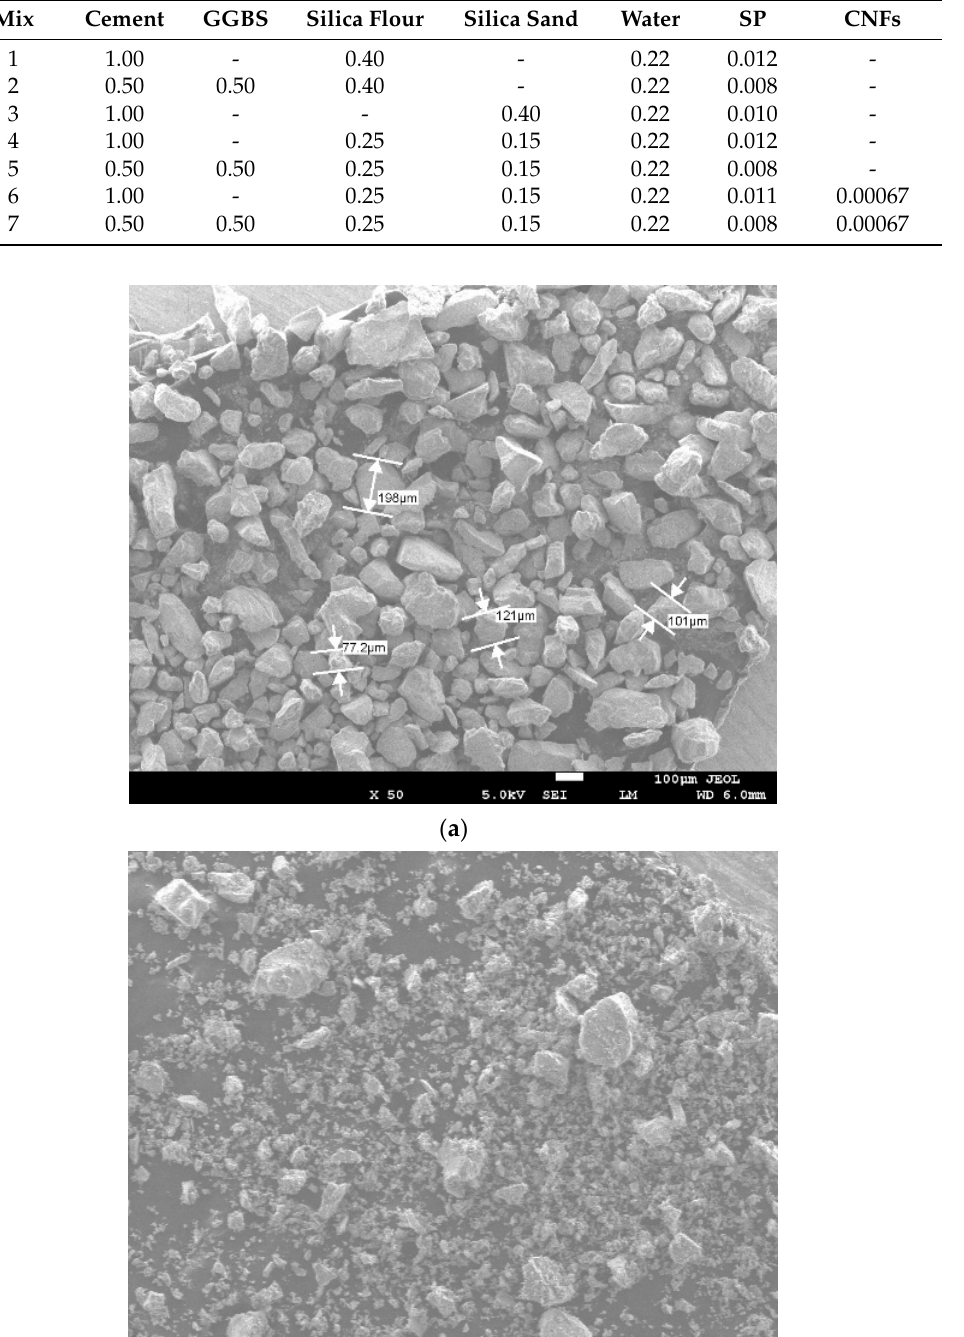
Table 2. Mix proportions of the designated concretes with and without CNFs.